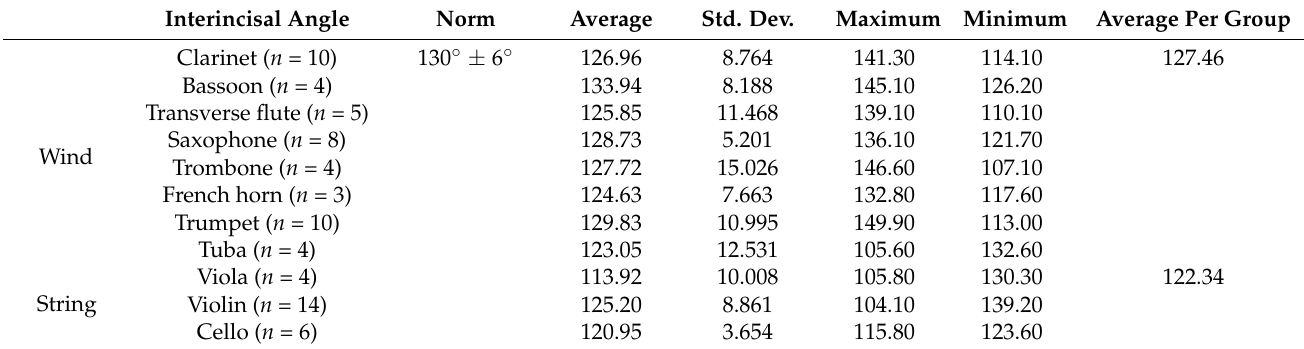
Table 1. Descriptive statistics for the variable interincisal angle.